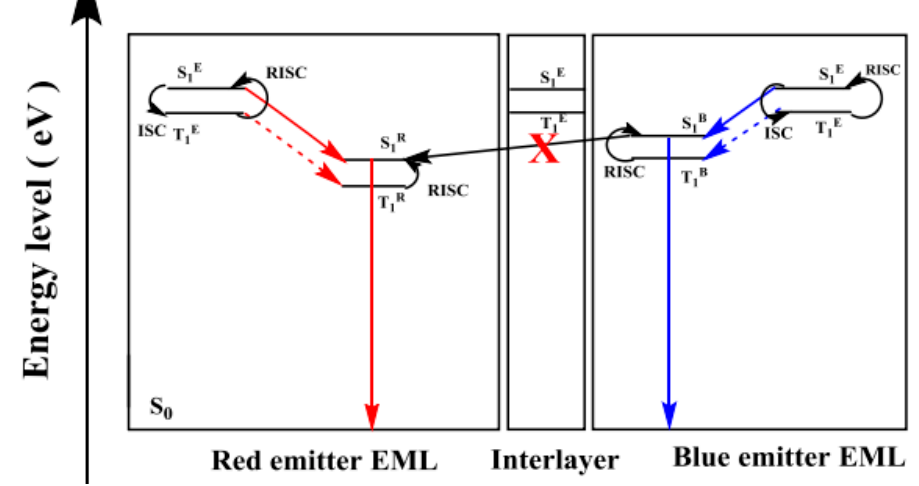
Figure 9. Exciton energies for exciplex hosts and decay channels for singlets as well as triplets. (Dash and solid arrows are Dexter and Förster energy transfer, respectively. The locking mark is singlets energy transfer stopping) [182].